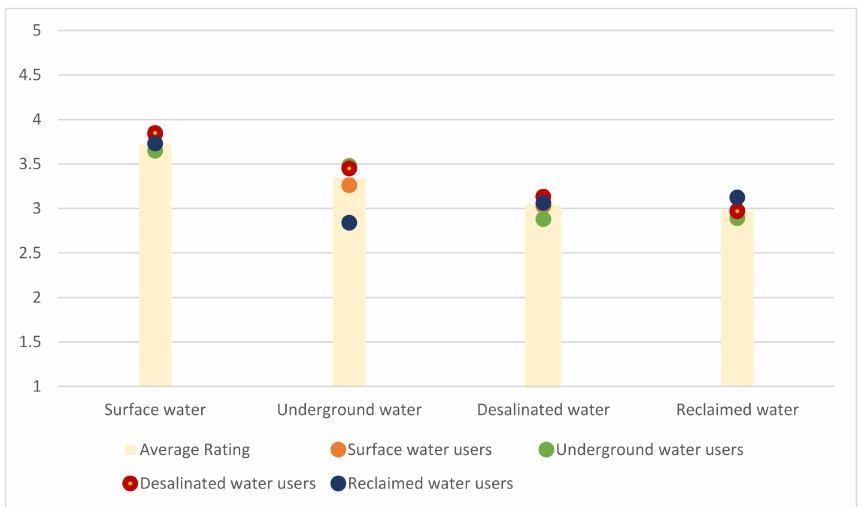
Figure 2. Farmers’ perceived water sources